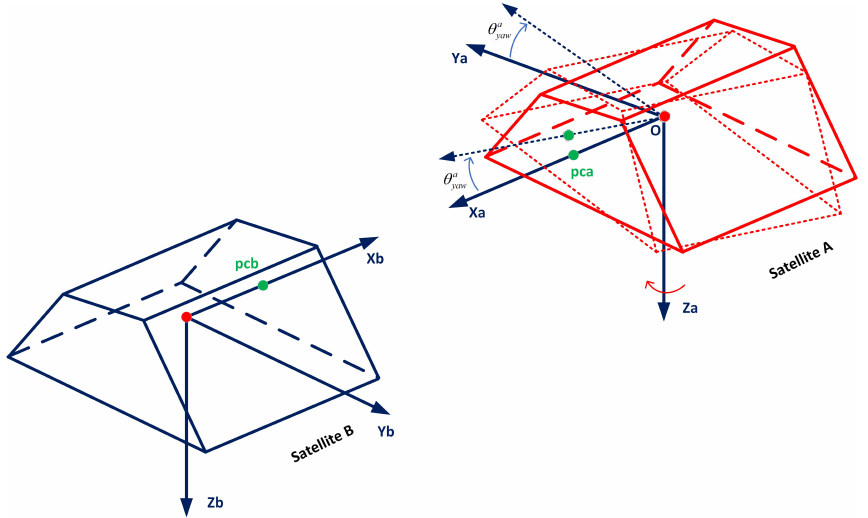
Figure 1. Illustration of sub-maneuver A (MA) for APC calibration, a small positive yaw angle maneuver is performed for satellite